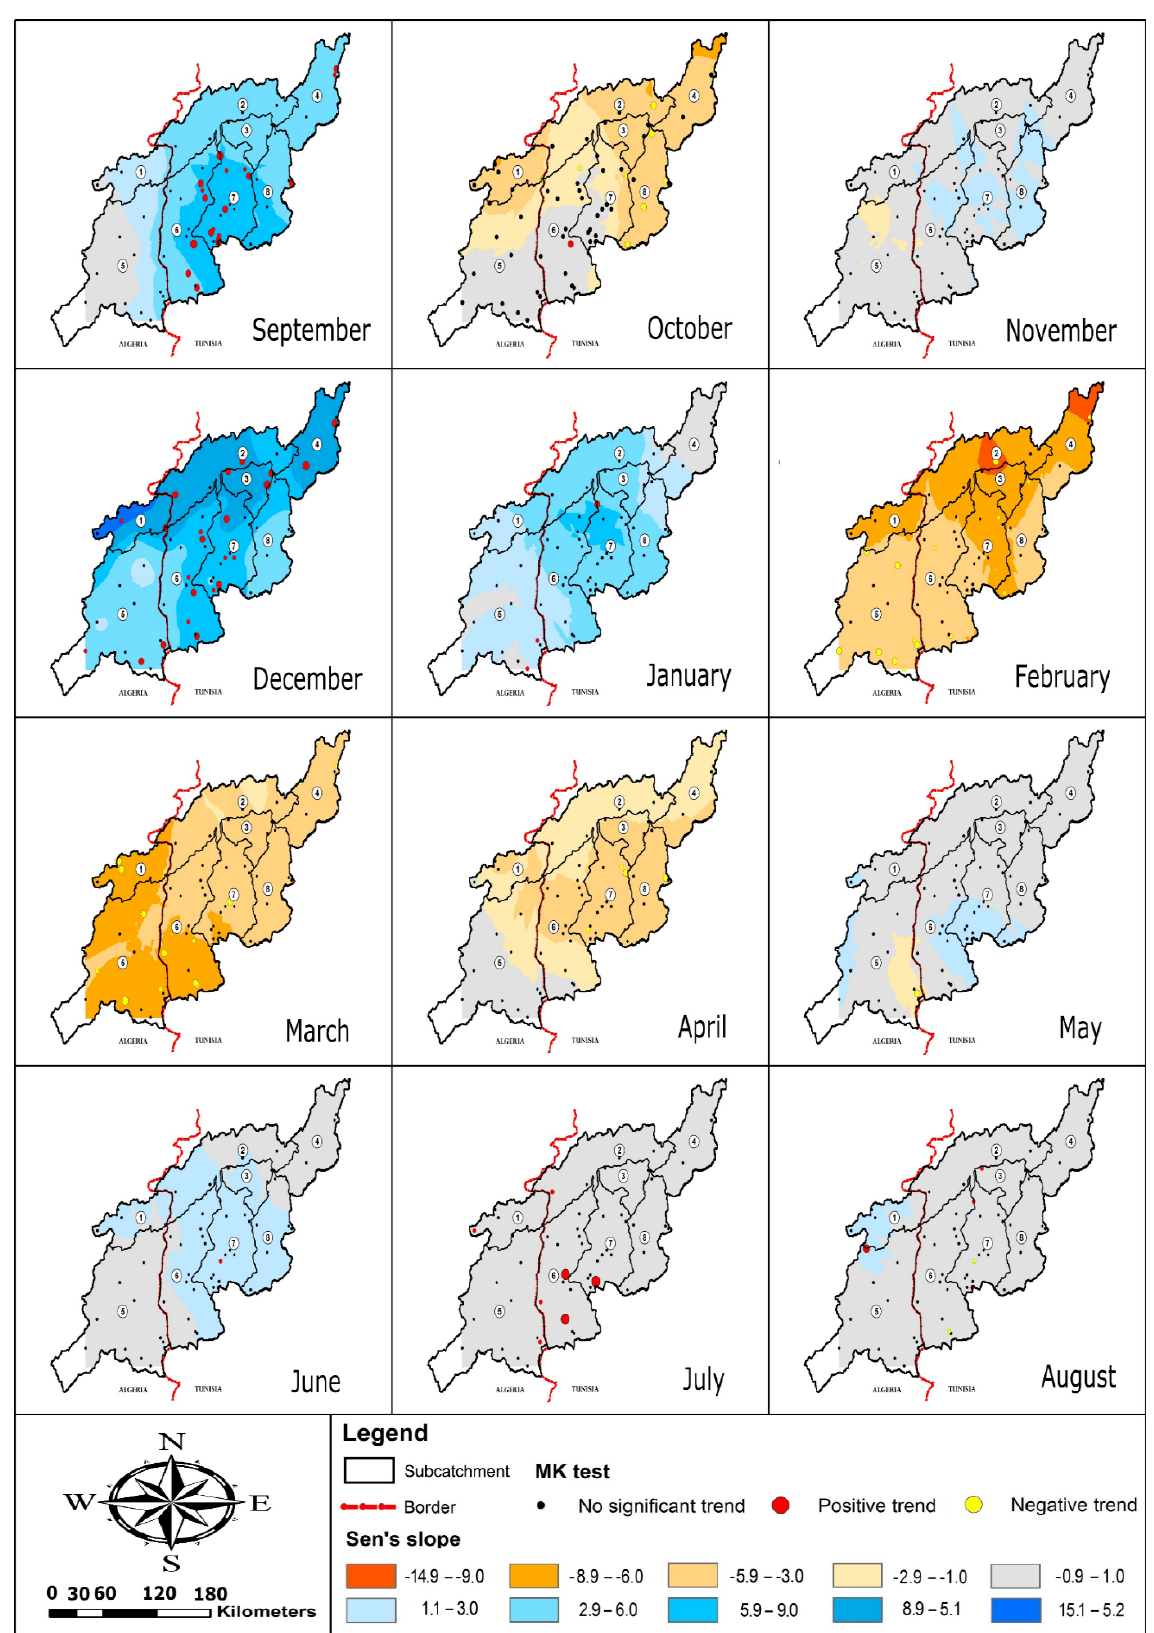
Figure 8. Spatial distribution of Sen’s slope and MK trend over the Medjerda Watershed at annual, seasonal scales. Red and yellow circles dimensions are related to MK significance level.